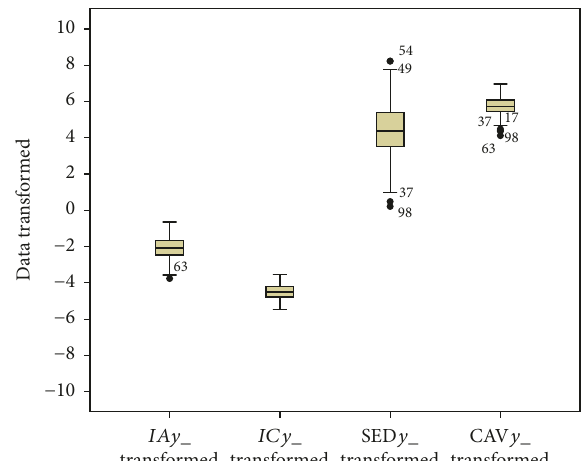
Figure 10: Box plot of data from the four features.